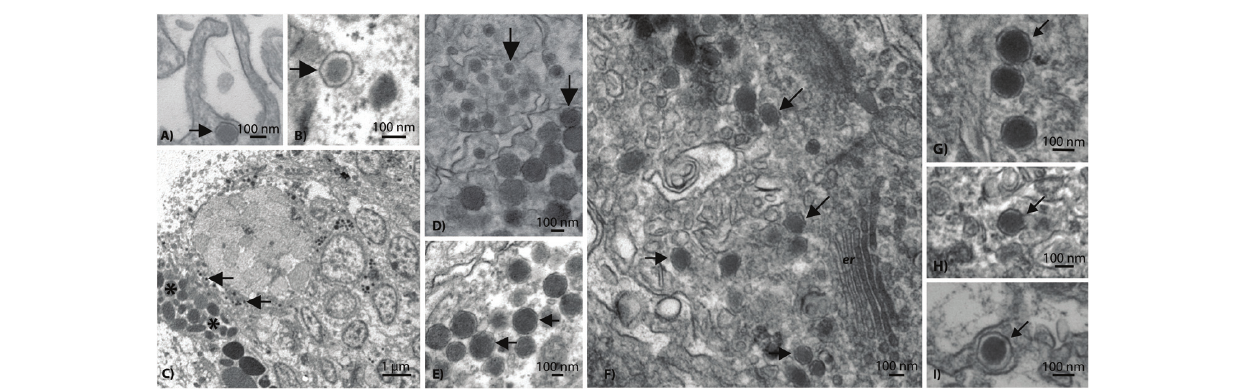
retrovirus-like VLPs ( ∼ 70 nm in diameter; Figures 7C,D